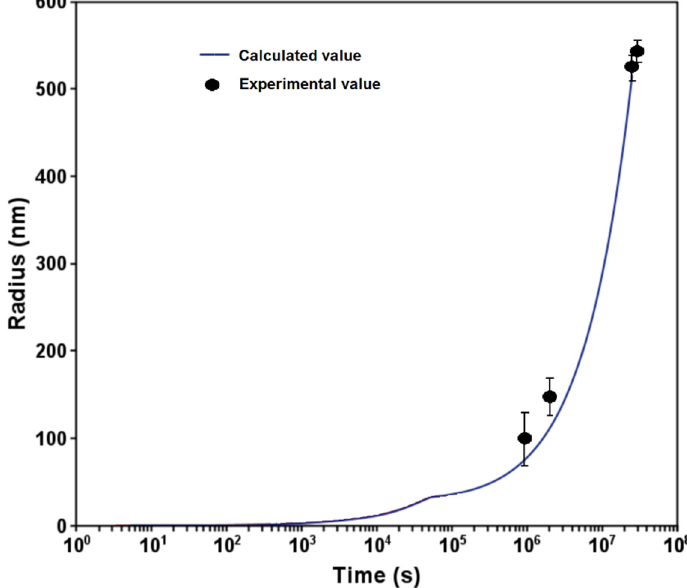
Figure 11. Calphad-calculated mean radius of precipitates vs. time during aging at 600 °C.